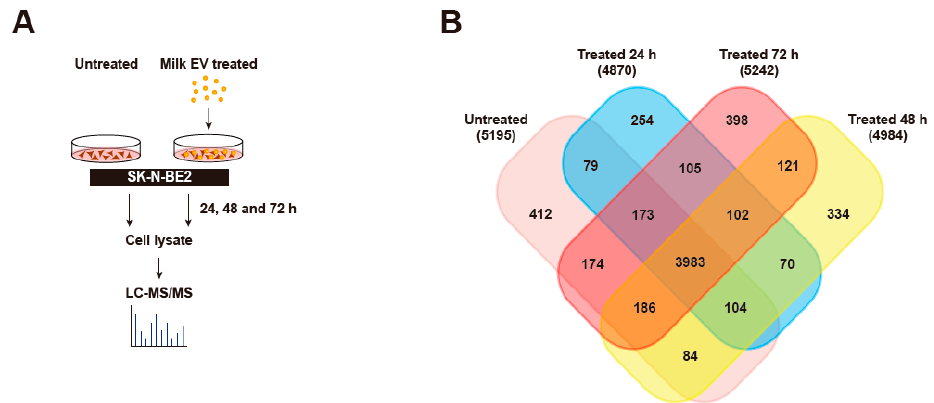
Figure 3. Proteomic analysis of cells treated with MEVs. ( A ) Schematic diagram of sample preparation from label-free quantitative proteomic analysis. ( B ) Venn diagram of proteins distributed between untreated, 24, 48 and 72 h MEVs (100 µg/mL) treated SK-N-BE2 cells. n = 3 biological replicates.